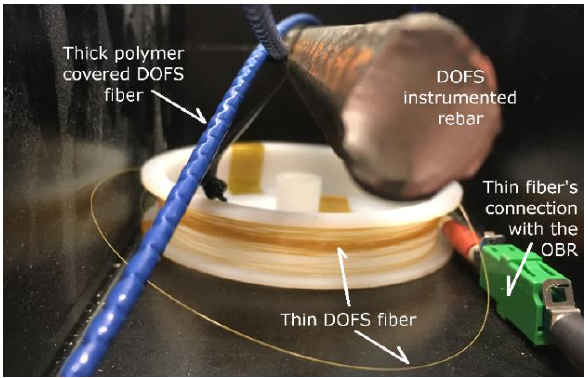
Figure 2. Thin polyamide cladded distributed optical fiber sensors (DOFS) (yellow) and thick polymer coated DOFS (blue).